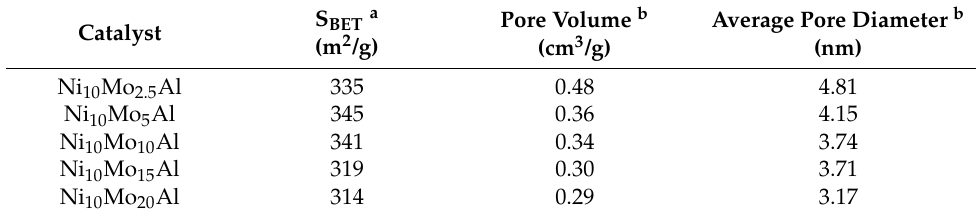
Table 2. Texture properties of Ni 10 Mo x Al catalysts.